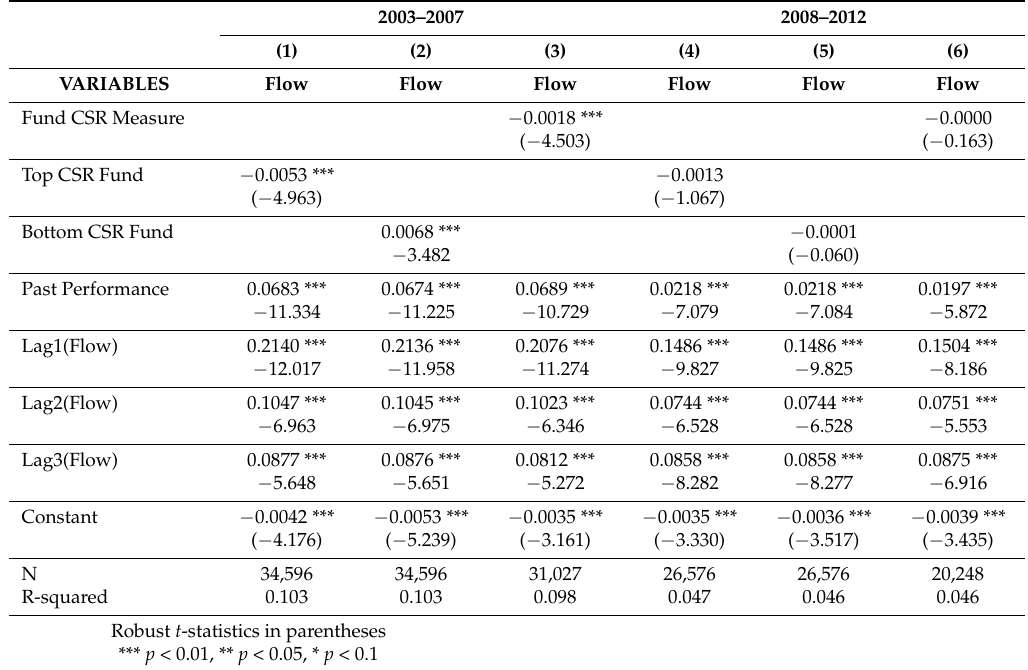
Table 3. CSR-funds and new investments: 2003–2007 and 2008–2012 sub-sample